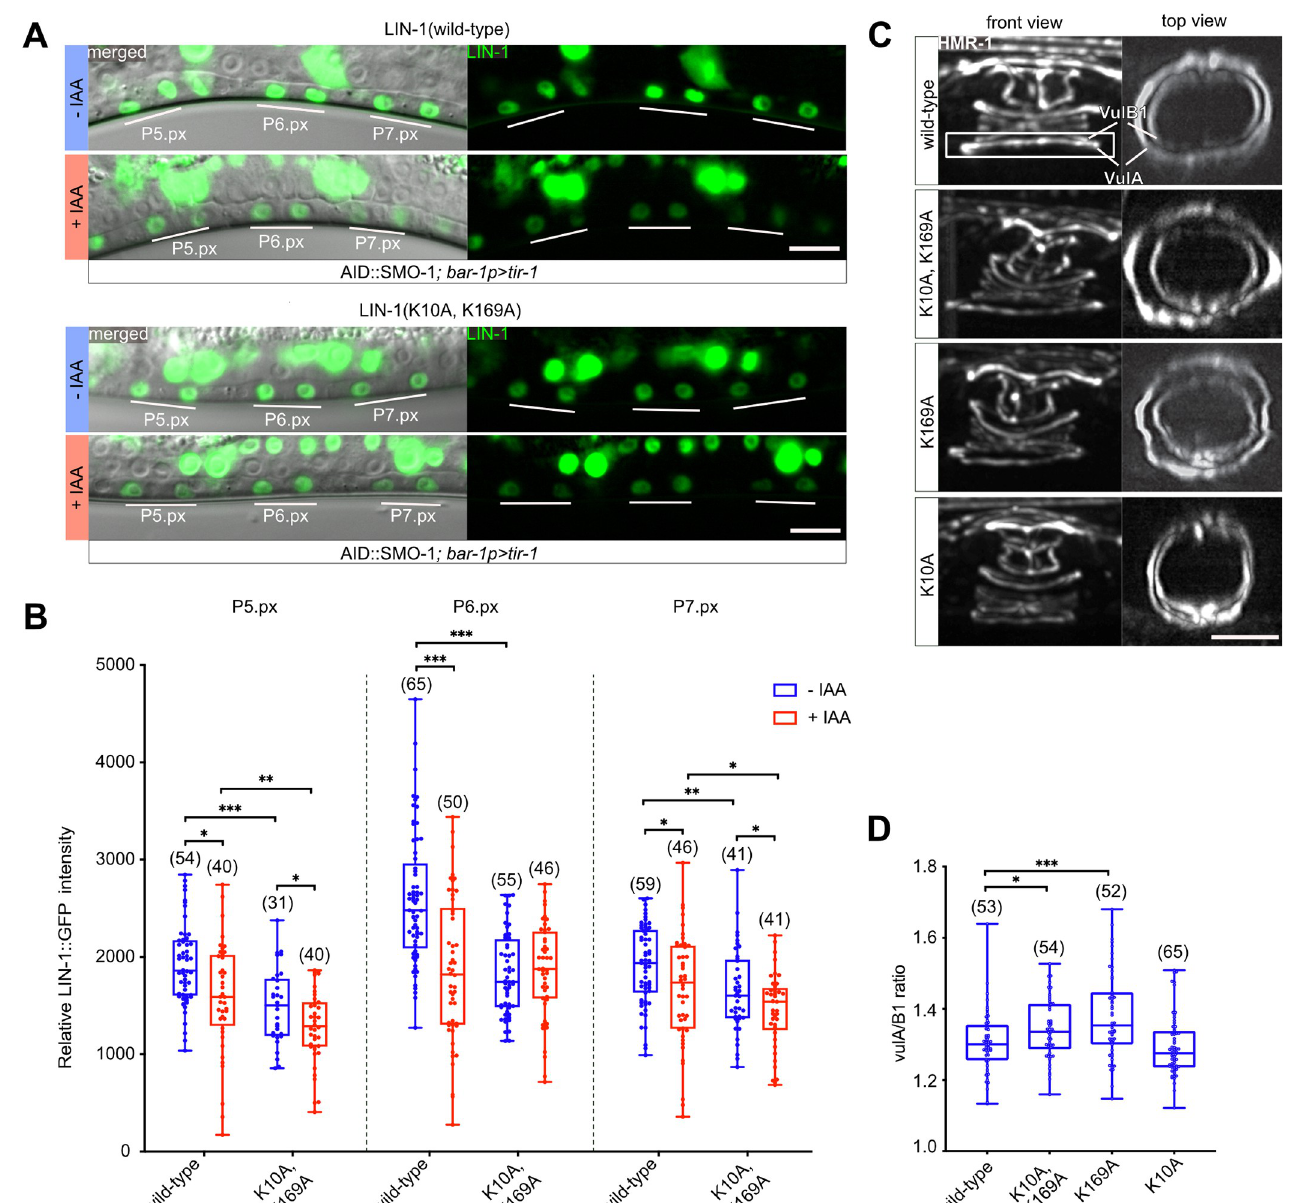
Fig 5. LIN-1 sumoylation is required for ventral toroid contraction. (A) Wild-type and K10A, K169A mutant LIN-1::GFP expression in L3 larvae at the Pn. px stage after VPC-specific degradation of AID::SMO-1 from the L2 stage onward. The 1˚ and 2˚ VPC descendants are underlined in white. The left panels show the corresponding DIC images overlaid with the LIN-1::GFP signal in green. (B) Quantification of LIN-1::GFP expression levels in 1˚ and 2˚ VPC descendants at the Pn.px stage in LIN-1::GFP wild-type and K10A, K169A double mutants under the indicated conditions. See S3 Fig for the corresponding measurements at the Pn.pxx stage. (C) Toroid morphogenesis defects in LIN-1 K10A and K169A single and double mutants at the L4 stage. Left panels show lateral views of z-projections. vulA and vulB1 toroids are outlined by the white rectangle in the top left panel and shown in top (xz) views in the right panels. (D) Quantification of vulA contraction, calculated as the ratio of the vulA and vulB1 toroid diameter. The box plots show the median values with the 25 th and 75 th percentiles and the whiskers indicate the maximum and minimum values. Where indicated, untreated controls are labelled with–IAA (blue) and animals treated with 1 mM auxin with +IAA (red). In each graph, the numbers of animals scored are indicated by the numbers in brackets. Statistical significance in (B) and ( D ) was calculated with unpaired two-tailed t-tests. p-values are indicated as � p � 0.05; �� p � 0.01; ��� p � 0.001. The scale bars are 10 μ m.